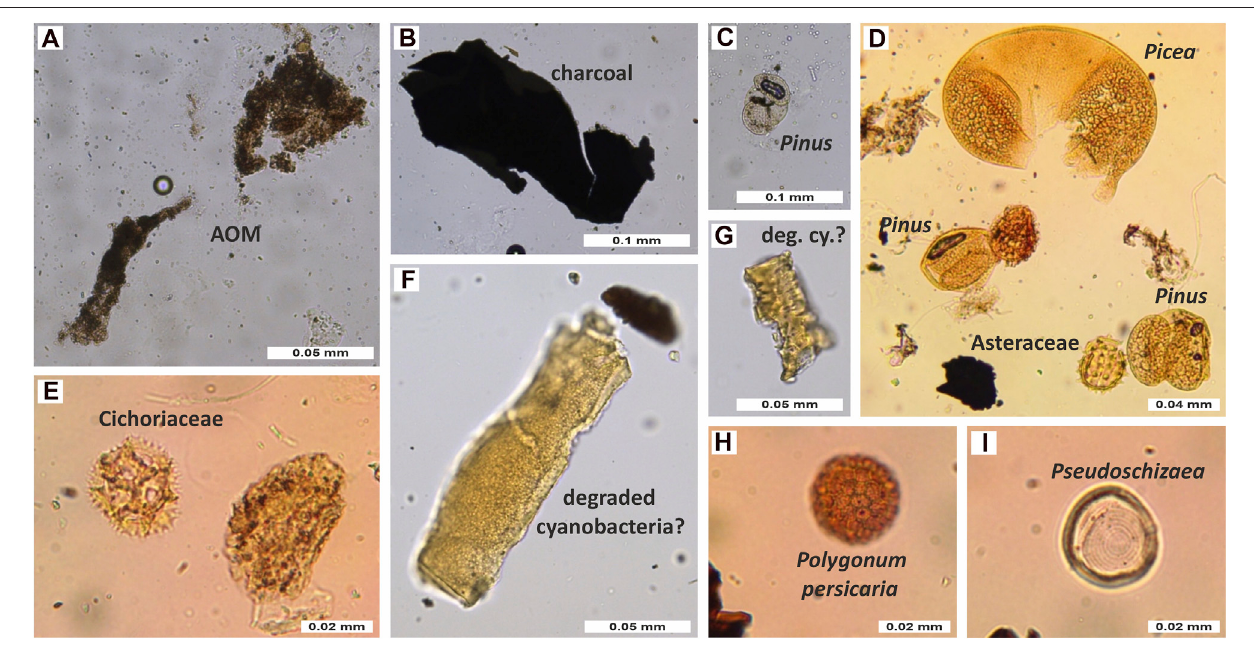
FIGURE 7 | Palynofacies from the pro fi le DC-SP in the Lower Cerova ˇ cka Cave (A,B) DC-SP 1, (C,D) DC-SP 2, (E,F) DC-SP 7, and (G,H) DC-SP 8.